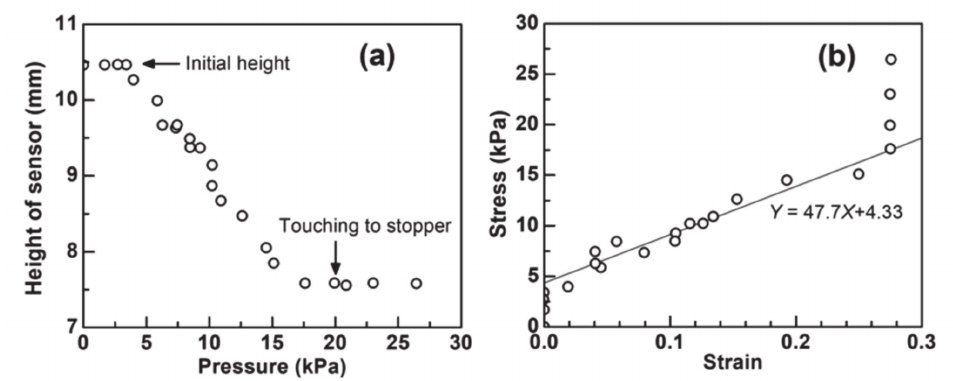
Figure 7. ( a ) Height of the sensor when a different amount of pressure was applied to the sensor. ( b ) Stress–strain plots for the